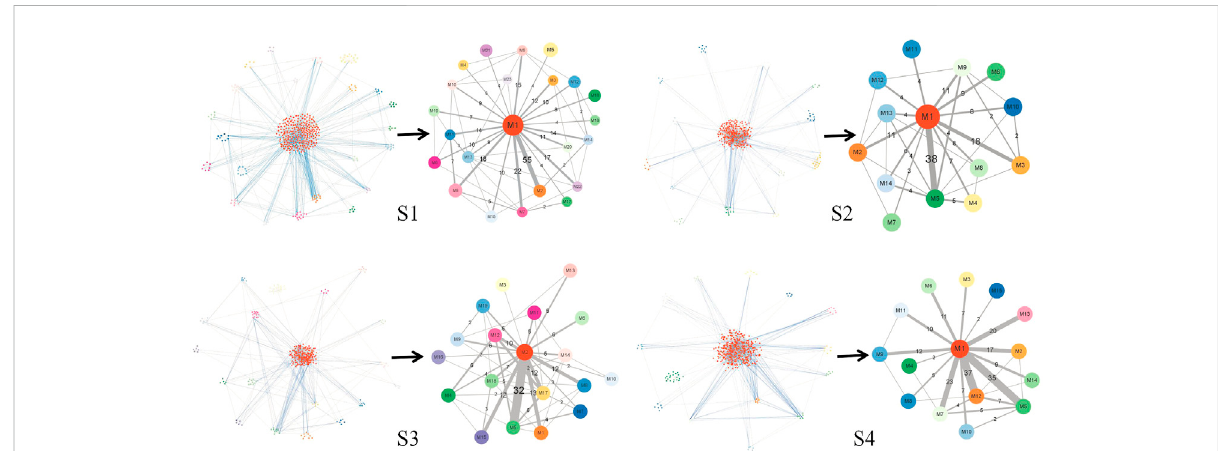
FIGURE 7 Modulenetworkand thesimpli fi edmodulenetwork in S 1to S 4.The fi gureineachstagehastwosub fi gures:theleftone isthemodulenetwork, with different colors representing biological molecules in different modules, blue edges connecting molecules within different modules, and gray edges connecting different modules; the right one is the simpli fi ed module path graph, where the letter M on vertices represents module and the numberafter M istheserialnumberofthemodule,thenumberonedgesrepresentsthenumberofedgesconnectingthetwomodules,andthe width of the edge represents the magnitude of the